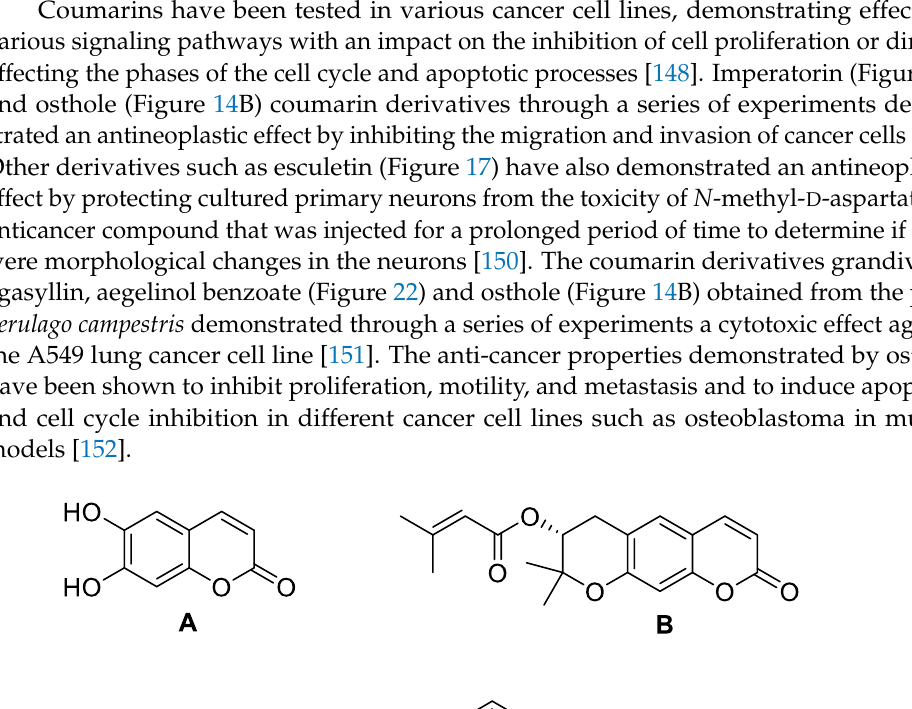
Table 2. Coumarin derivatives and their antineoplastic function.